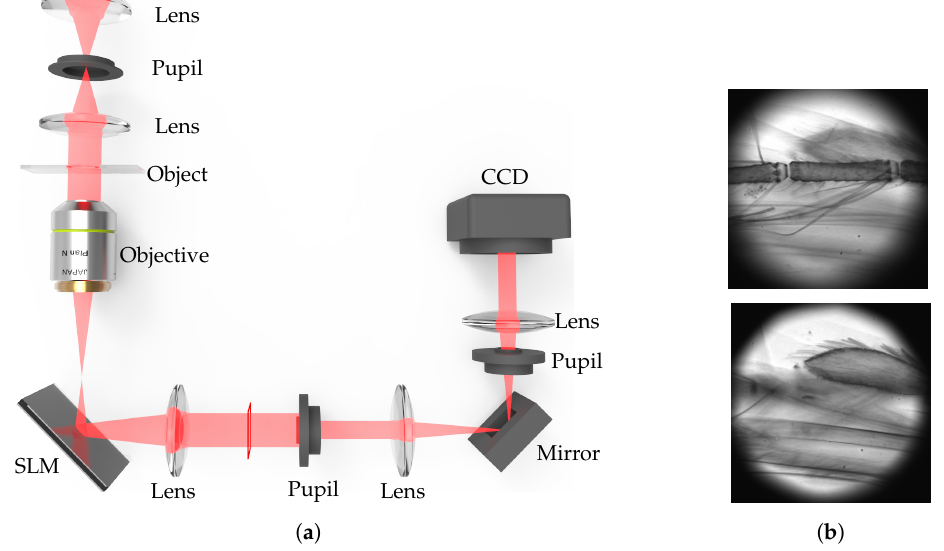
Figure 12. System setup ( a ) and two of the captured out of focus images ( b ) of the fast light ray field acquisition with point spread function (PSF) modulation (Adapted with permission from [64], Optical Society of America). SLM: spatial light modulator; CCD; Charge-coupled